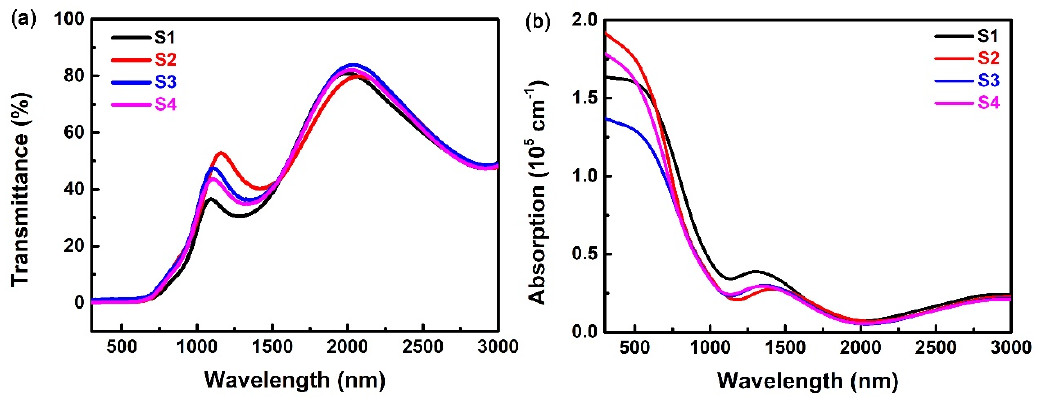
Figure 6. The ( a ) transmittance and ( b ) absorption spectra of Ta-doped InTe thin films S1–S4.